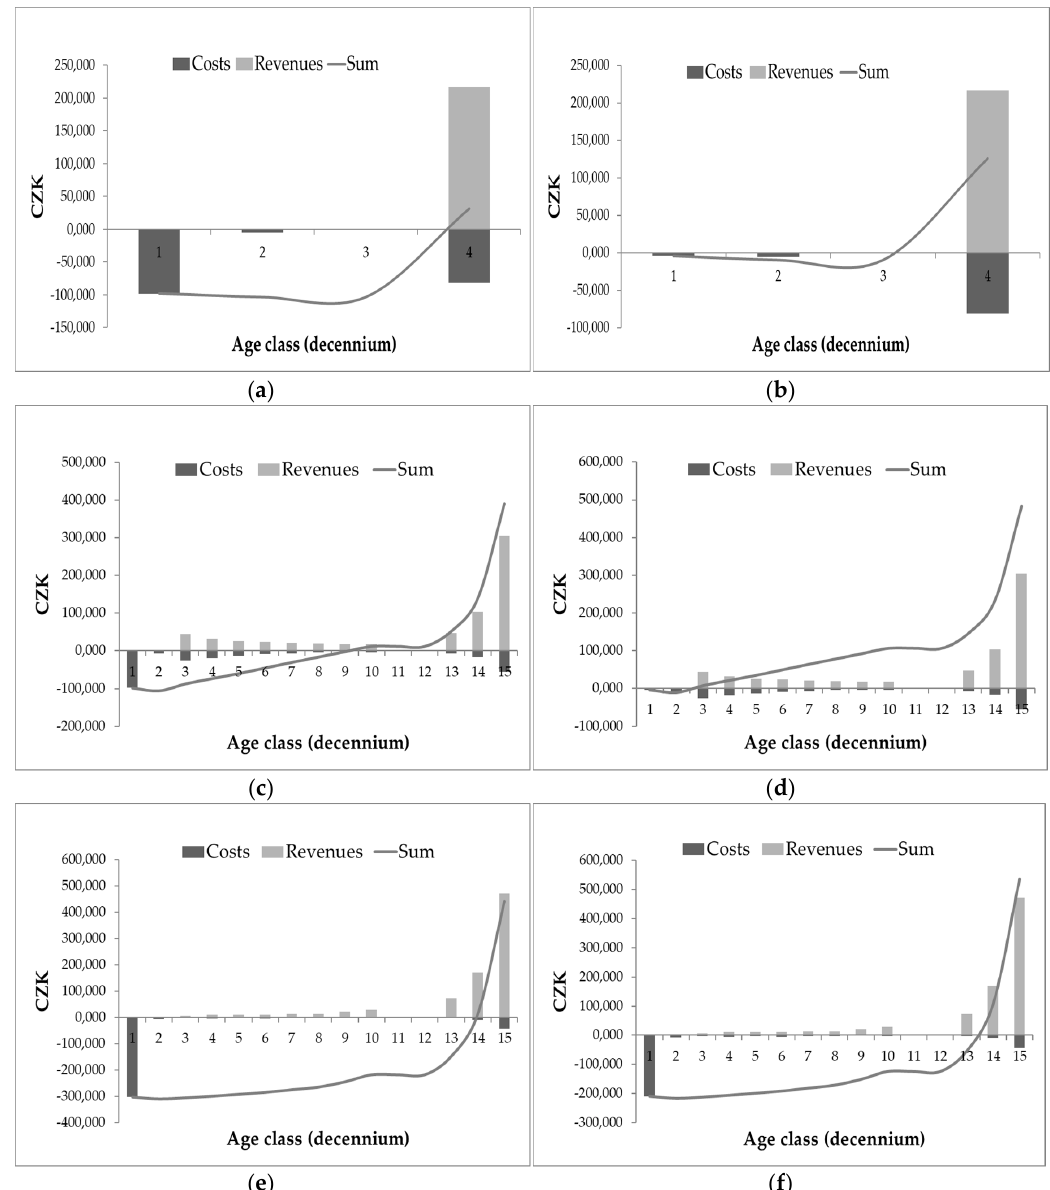
Figure 4. Course of costs and revenues through the whole rotation period for the individual examined variants (without regard to time factor). ( a ) Course of costs and revenues—coppice I_II with game